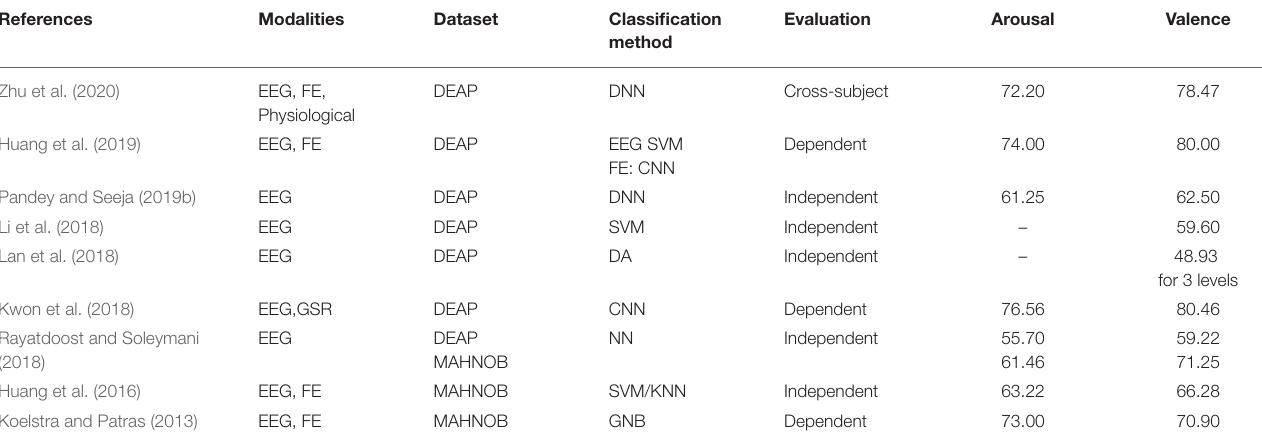
TABLE 1 | Comparison of recent related works that used the DEAP or MAHNOB-HCI